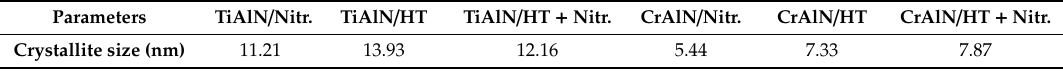
Table 2. Crystallite size measured at TiAlN (111) and CrAlN (111) using Fe-k α .